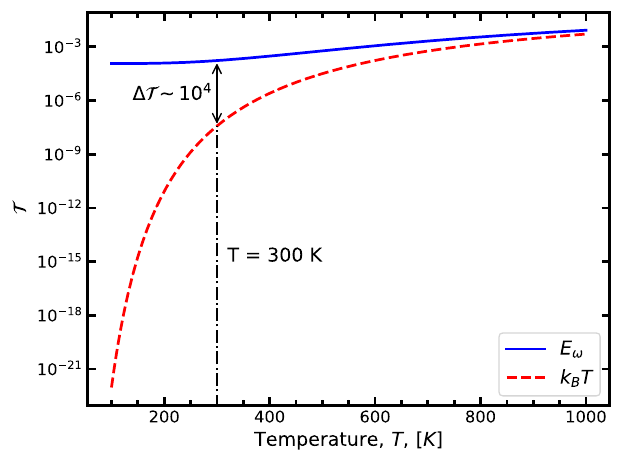
Fig. 4 Tautomeric occupation probability. The tautomeric occupation probability is plotted as a function of bath temperature. The low- temperature corrected result, using E ω , is shown as the solid line in blue and the high-temperature approach, k B T , as a dashed